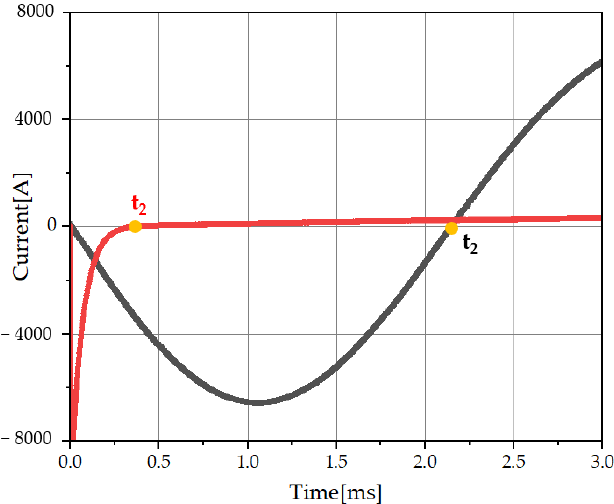
Figure 3. Comparison of current zero-crossing time t 2 between non-system inductance (Red) and system inductance L L = 1 mH (Black).